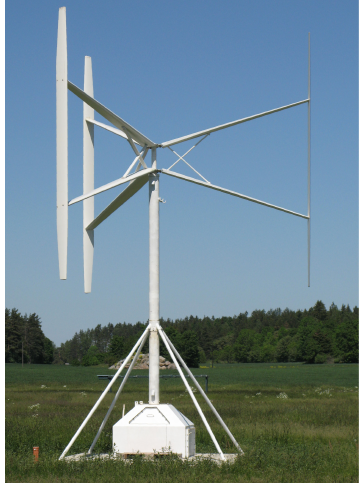
Figure 7. Three bladed 12 kW prototype vertical axis wind turbine located north of Uppsala.